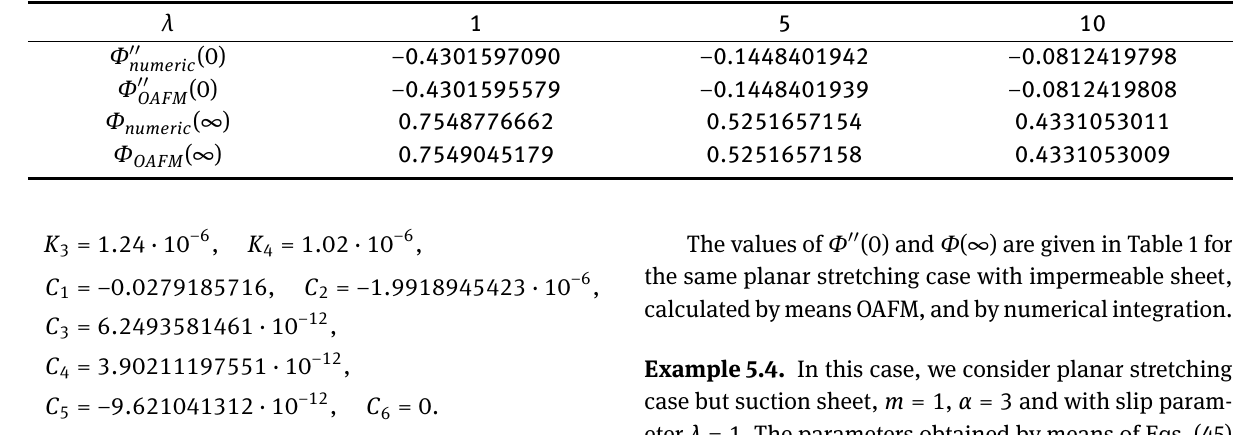
Table 1: Values of Φ ′′ (0) and Φ (∞) in the case of planar stretching case with impermeable sheet m = 1 , α =